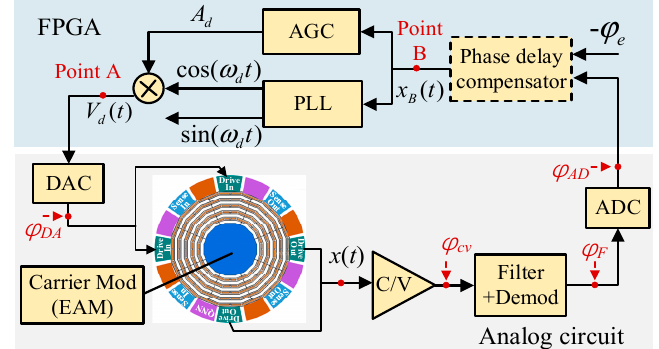
Figure 1. The control scheme of the drive mode.